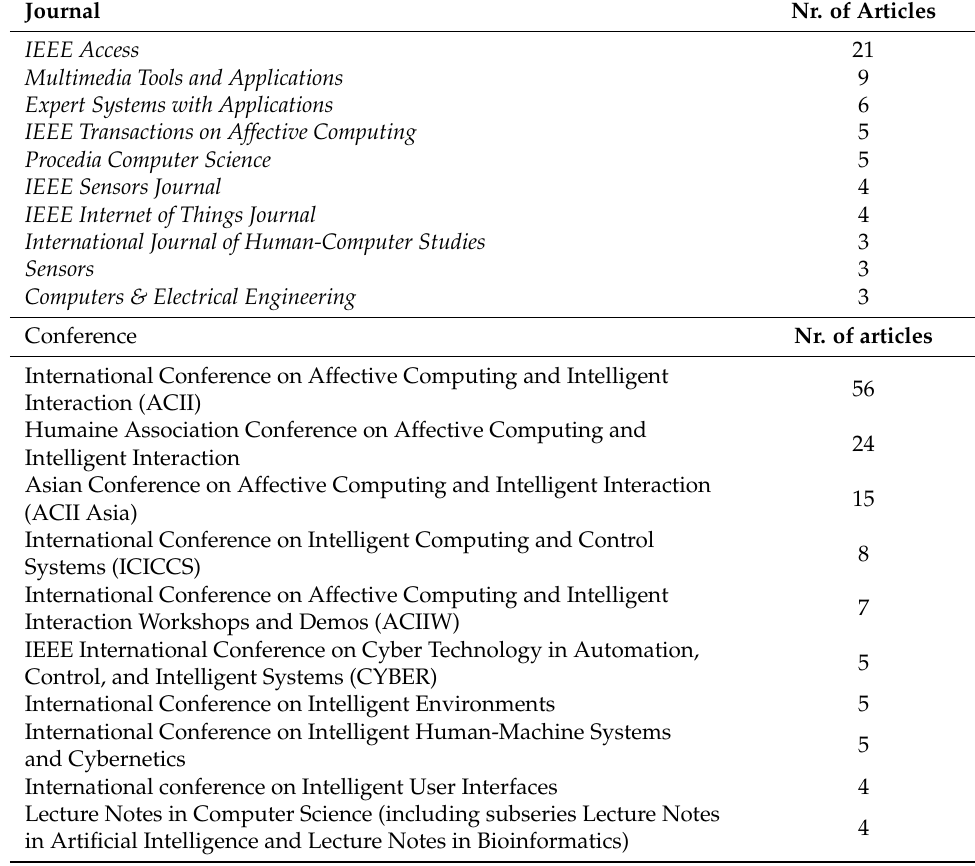
Table 6. Top ten journals and conferences regarding the number of published articles.